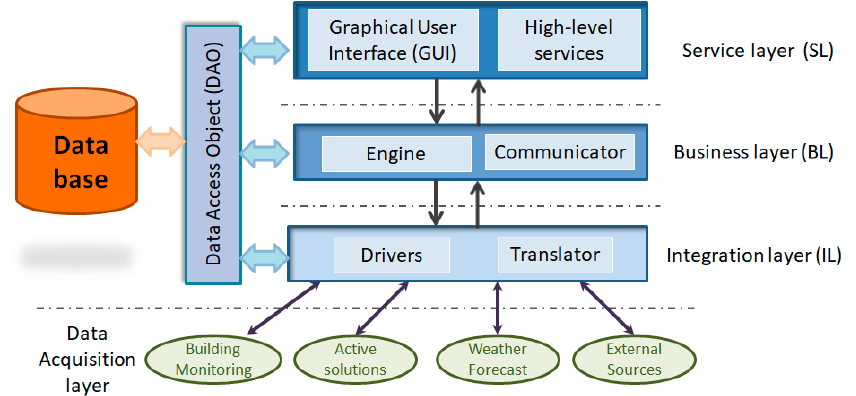
Figure 1. BRESAER BEMS system architecture.